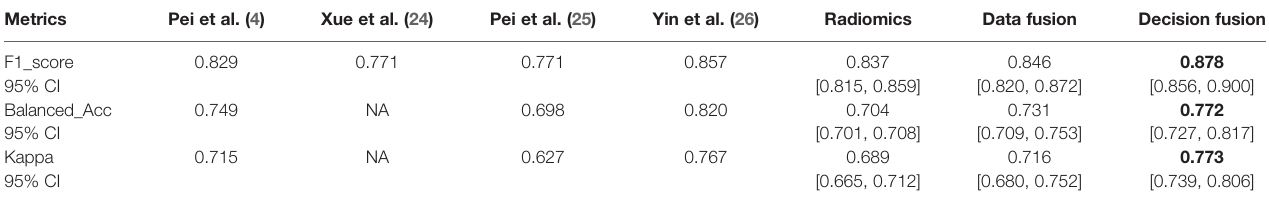
TABLE 3 | Performance comparison of other state-of-the-art studies with ours. Metrics